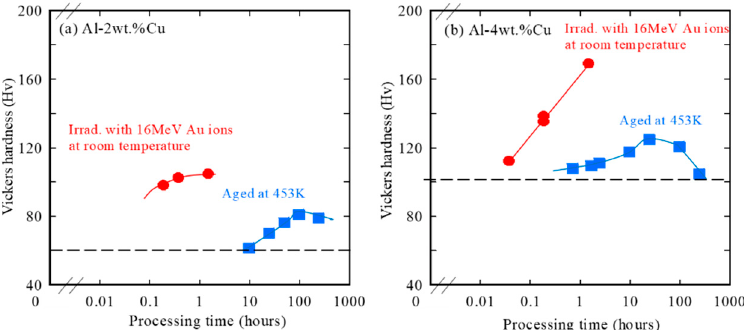
Figure 5. Vickers hardness of ( a ) Al-2wt %Cu alloy and ( b ) Al-4wt %Cu alloy as a function of processing time. Solid circles for specimens irradiated with 16 MeV Au ions and solid squares for those thermally aged at 453 K. Dashed lines show the hardness values before irradiation or thermal aging.